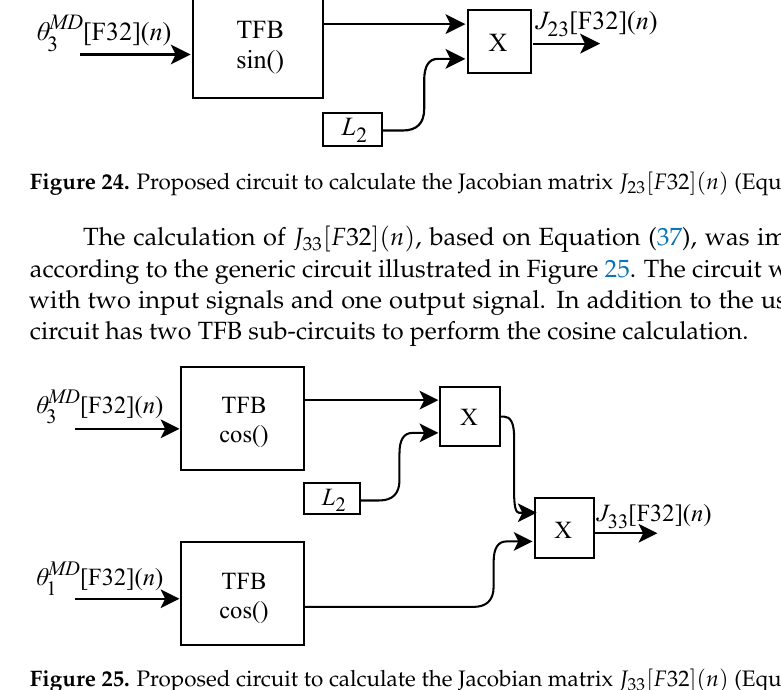
Figure 25. Proposed circuit to calculate the Jacobian matrix J 33 [ F 32 ]( n ) (Equation